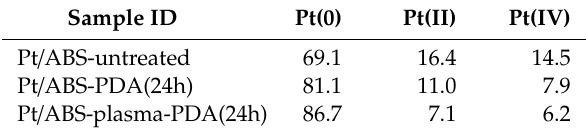
Figure 10. Pt4f-XPS spectra of the Pt / ABS samples with or without plasma treatment and with or without PDA coating. Table 1. Ratios of Pt(0), Pt(II), and Pt(IV) calculated from peak resolution of the Pt4f 7 / 2 in Figure 10.